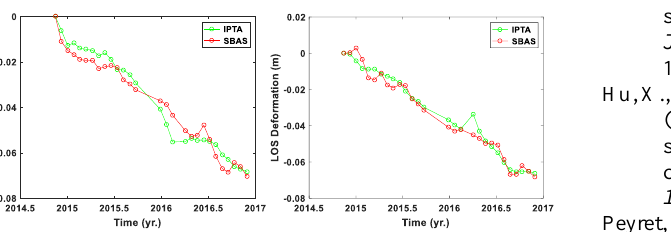
Figure 8. Deformation rate map extracted from the SBAS time series analysis results superimposed on the Google-earth image. The locations of sample points are also depicted.